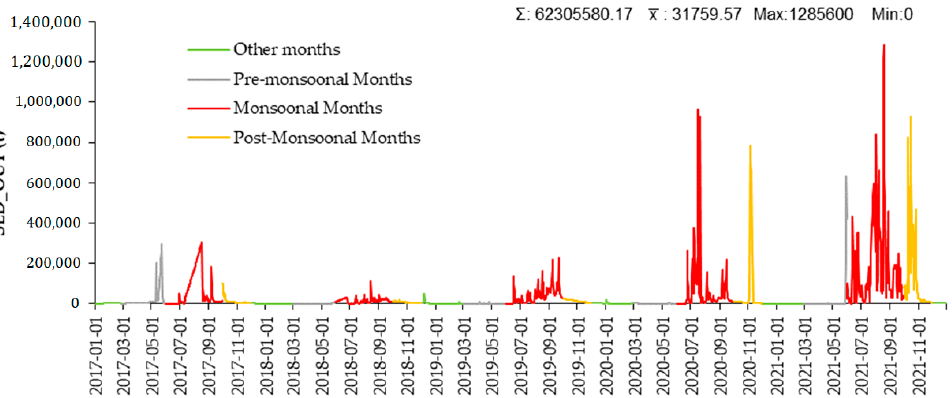
Figure 9. Simulated hydrographs displaying daily sediment outflux (SED_OUT) and its variations during pre-monsoon, monsoon, and post-monsoon.